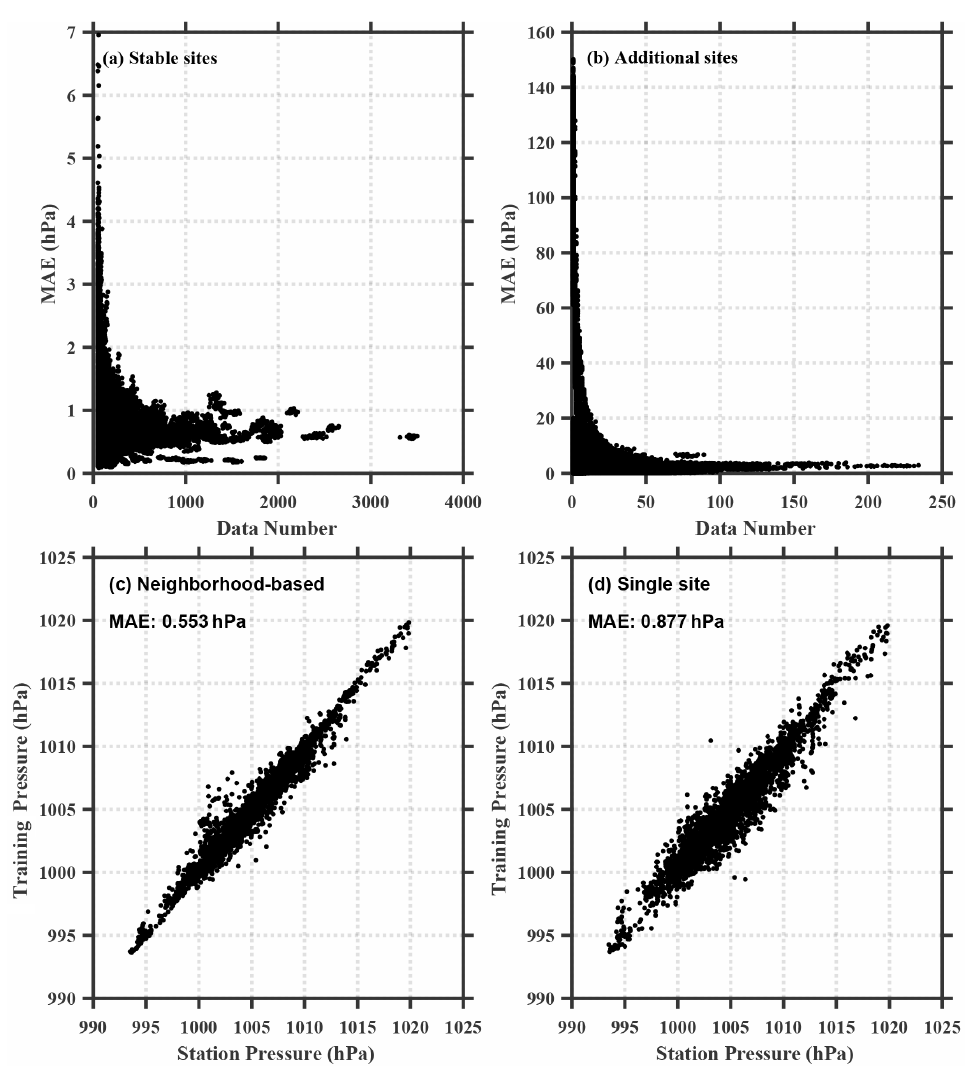
Figure 11. (a, b) Scatter plot of mean absolute error (MAE) versus the data number of observation sites for (a) stable sites and (b) additional sites. (c, d) Scatter plot of station pressure versus bias-corrected pressure for (c) the neighborhood-based method and (b) single-site method of one ensemble member. Averaged mean absolute errors (MAEs) of the two methods are shown in the